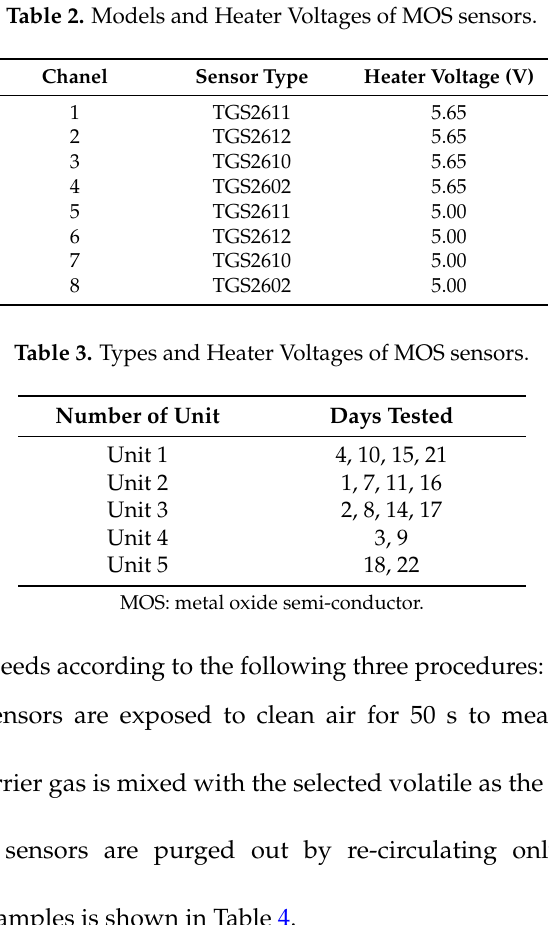
Table 4. Amount of samples in Dataset II.